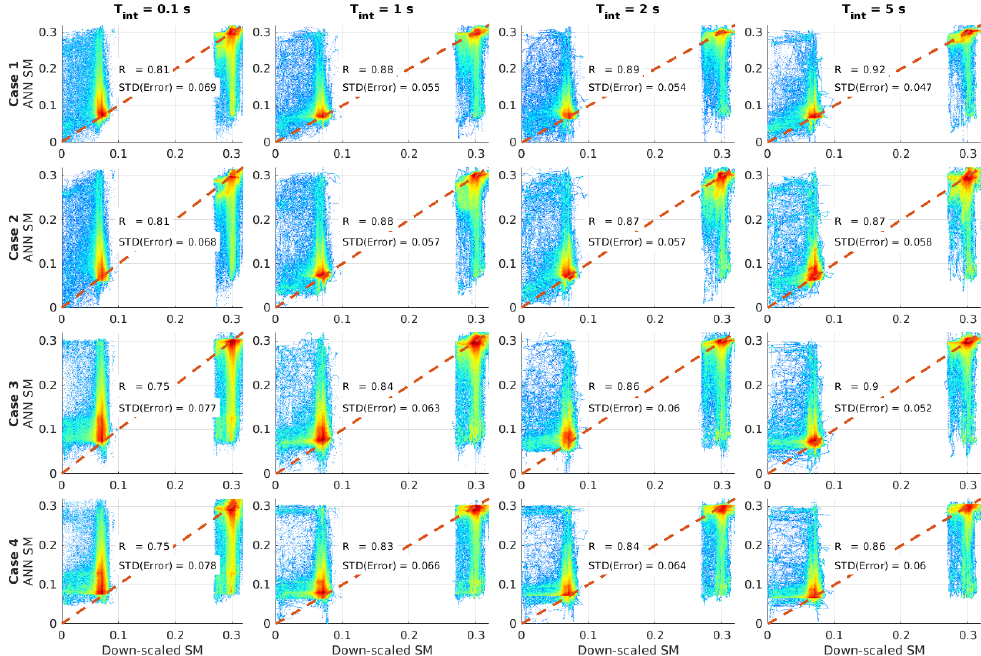
Figure 14. ANN estimated SM vs. SMOS/Sentinel-2 downscaled SM at L1. Columns from left to right increasing T int for 0.1, 1, 2, and 5 s. Row from top to bottom, ANN cases 1 to 4.